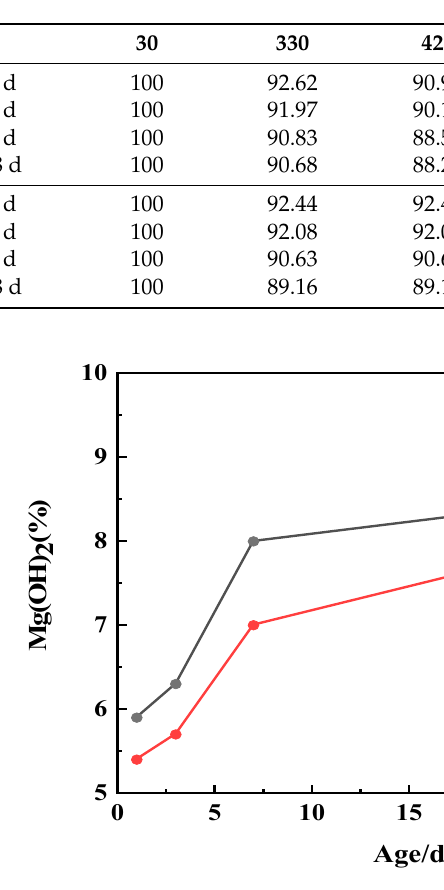
Figure 6. TG diagrams of cement slurry at 1 d, 3 d, 7 d and 28 d. ( a ) The TG curves of the blank group at 4 instars; ( b ) is the TG curve of 4 instars of hydration temperature rise inhibitor containing 1.0%SBT. Table 3. The mass fraction of each sample at different temperatures.